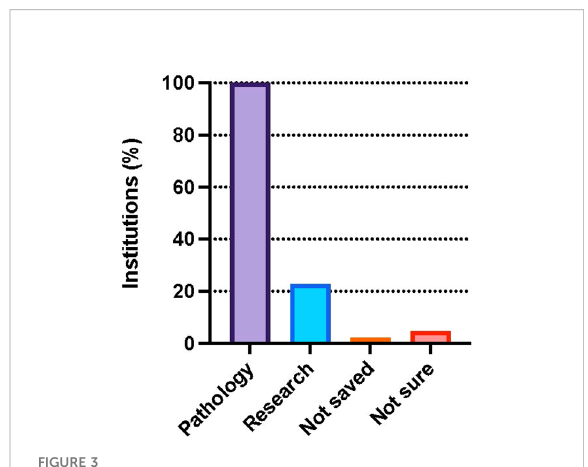
FIGURE 3 Percent of institutions that participated in the survey and perform pathology (100.0%) and research (22.7%) on tissue isolated from DSD patients. Few institutions reported tissue is